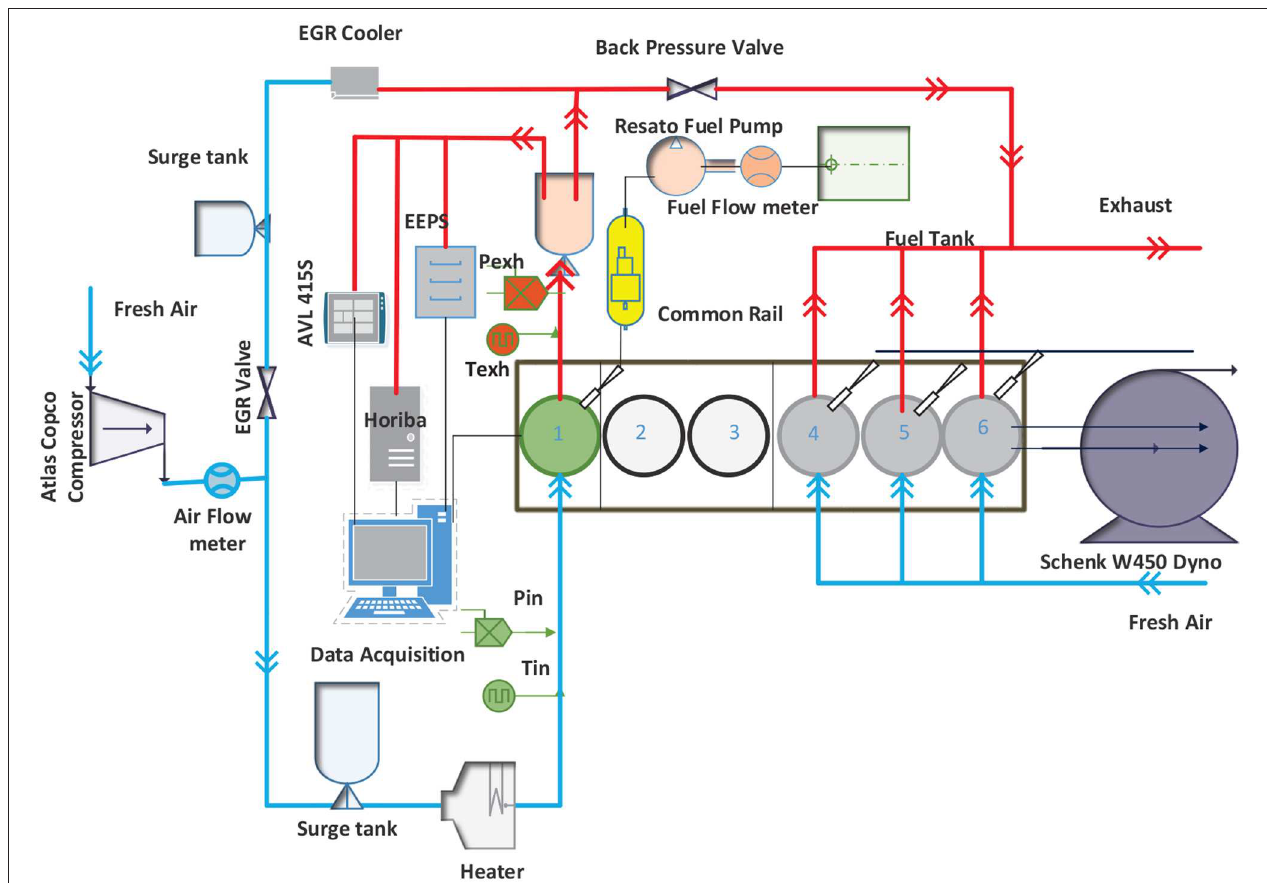
FIGURE 1 | Experimental